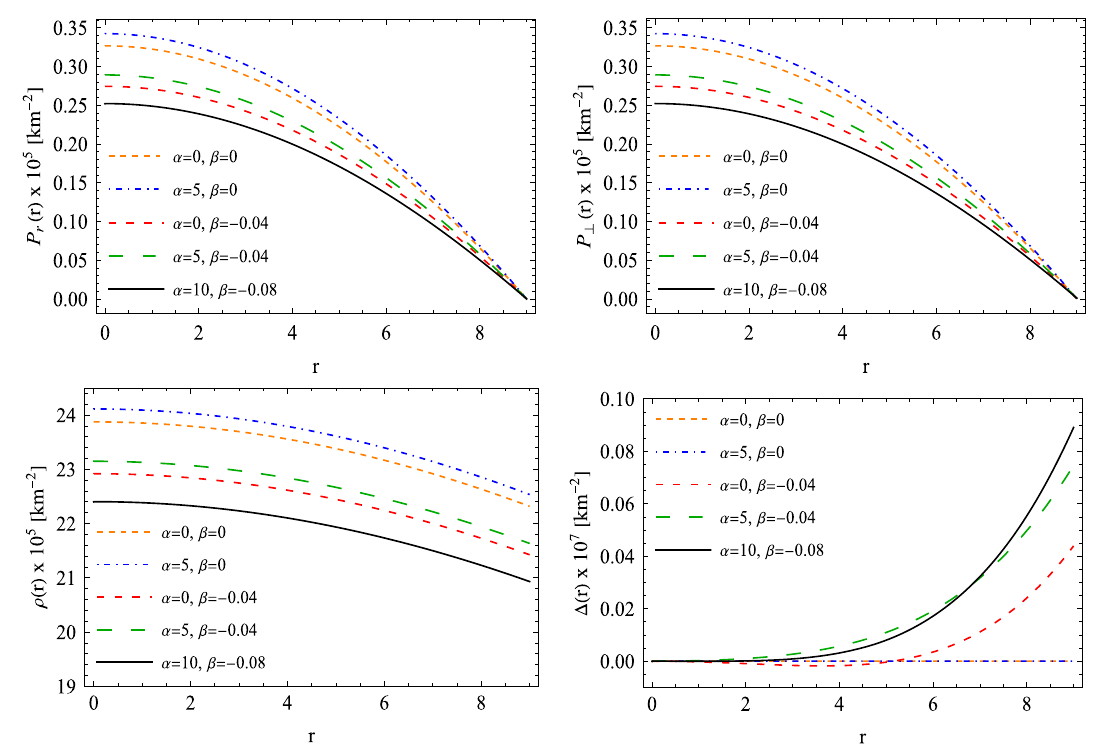
Fig. 2 The behavior of radial pressure P r ( r ) - top left, tangential pressure P ⊥ -top right, energy density ρ( r ) -bottom left, anisotropy factor (cid:2)( r ) -bottom right versus radial coordinate r for the solution Sect. 3.1